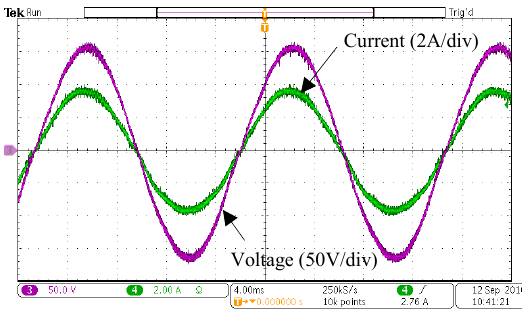
Fig. 15. Output voltage and output current when L g = 19.5 mH ( k p = 3)